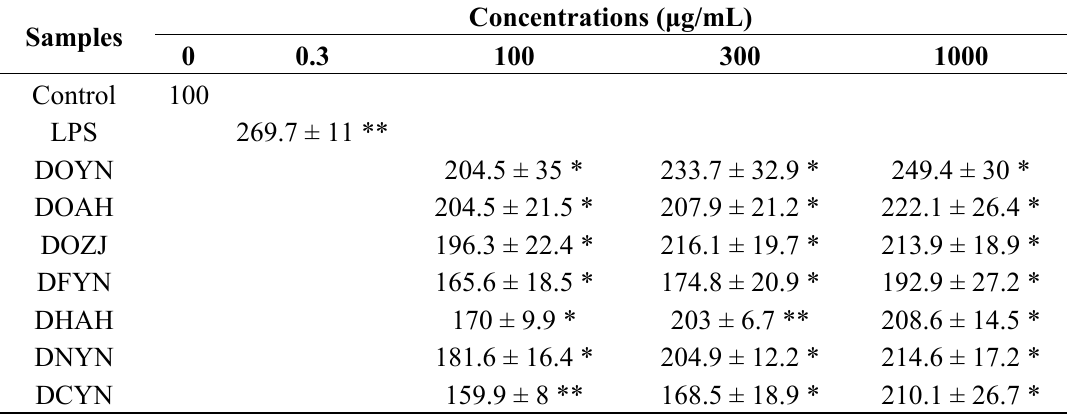
Table 3. Effects of crude polysaccharides from Dendrobium on phagocytosis of RAW 264.7 macrophages.